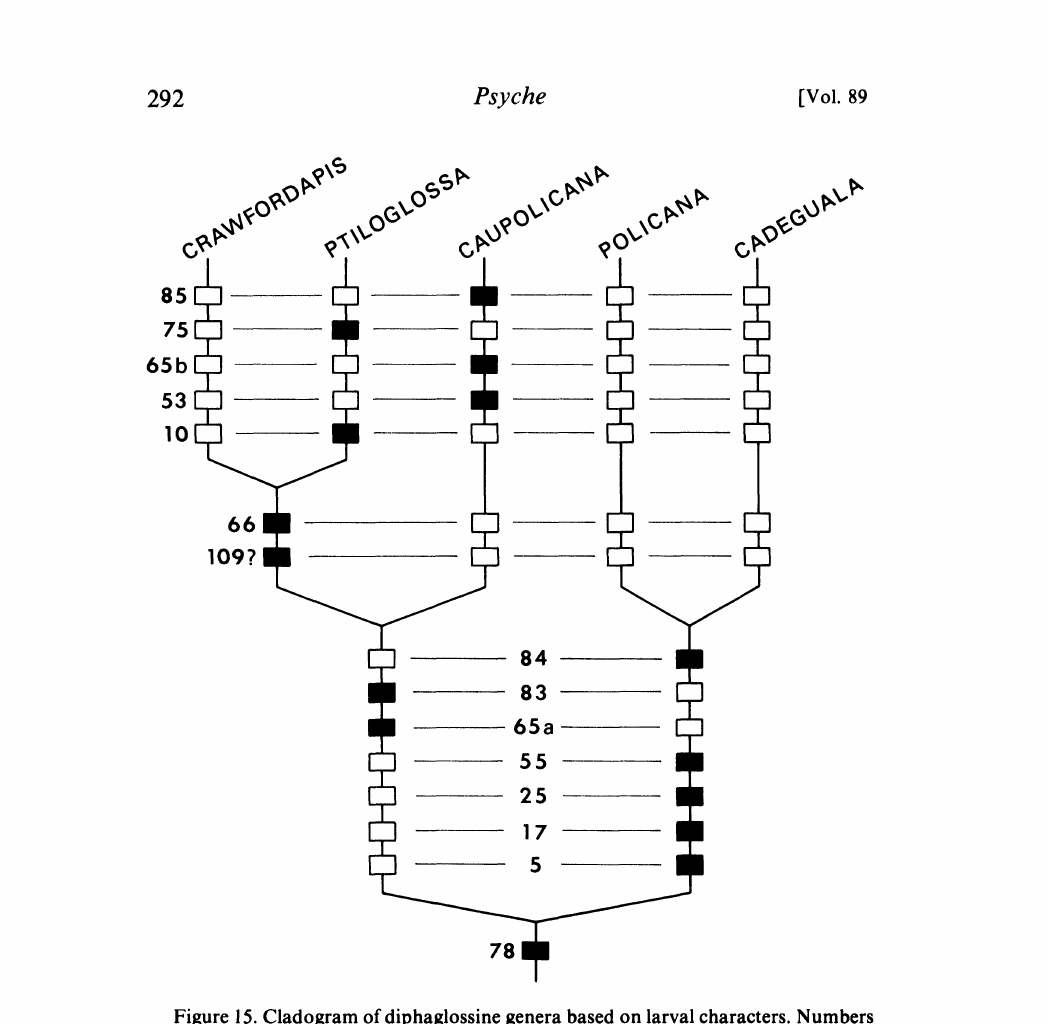
Figure 15. Cladogram of diphaglossine genera based on larval characters. Numbers refer to the characters listed in Table 3. Black rectangles represent presumed apo- morphic characters; white rectangles represent plesiomorphic characters. Character 109 appears to be variable in